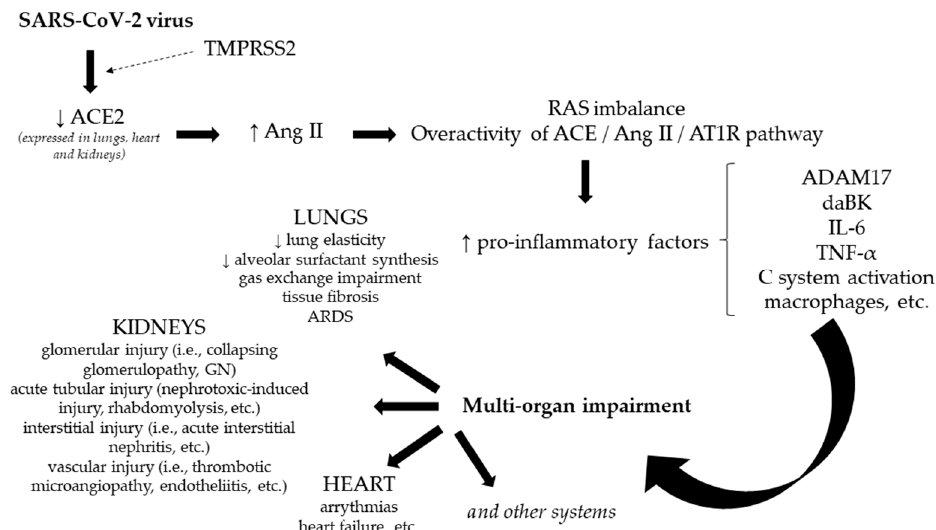
Figure 1. The link between SARS-CoV-2 infection and multi-organ impairment. Notes: ACE2—angiotensin-converting enzyme 2; ADAM17—a disintegrin and metalloproteinase 17 protease; Ang II—angiotensin II; ARDS—acute respiratory distress syndrome; TMPRSS2—transmembrane serine protease 2; AT1R—angiotensin II type 1 receptor; C system—complement system; daBK— des arginine9-bradikinine; GN—glomerulonephritis; IL-6—interleukin-6; RAS—renin–angiotensin system; TNF- α —tumor necrosis factor